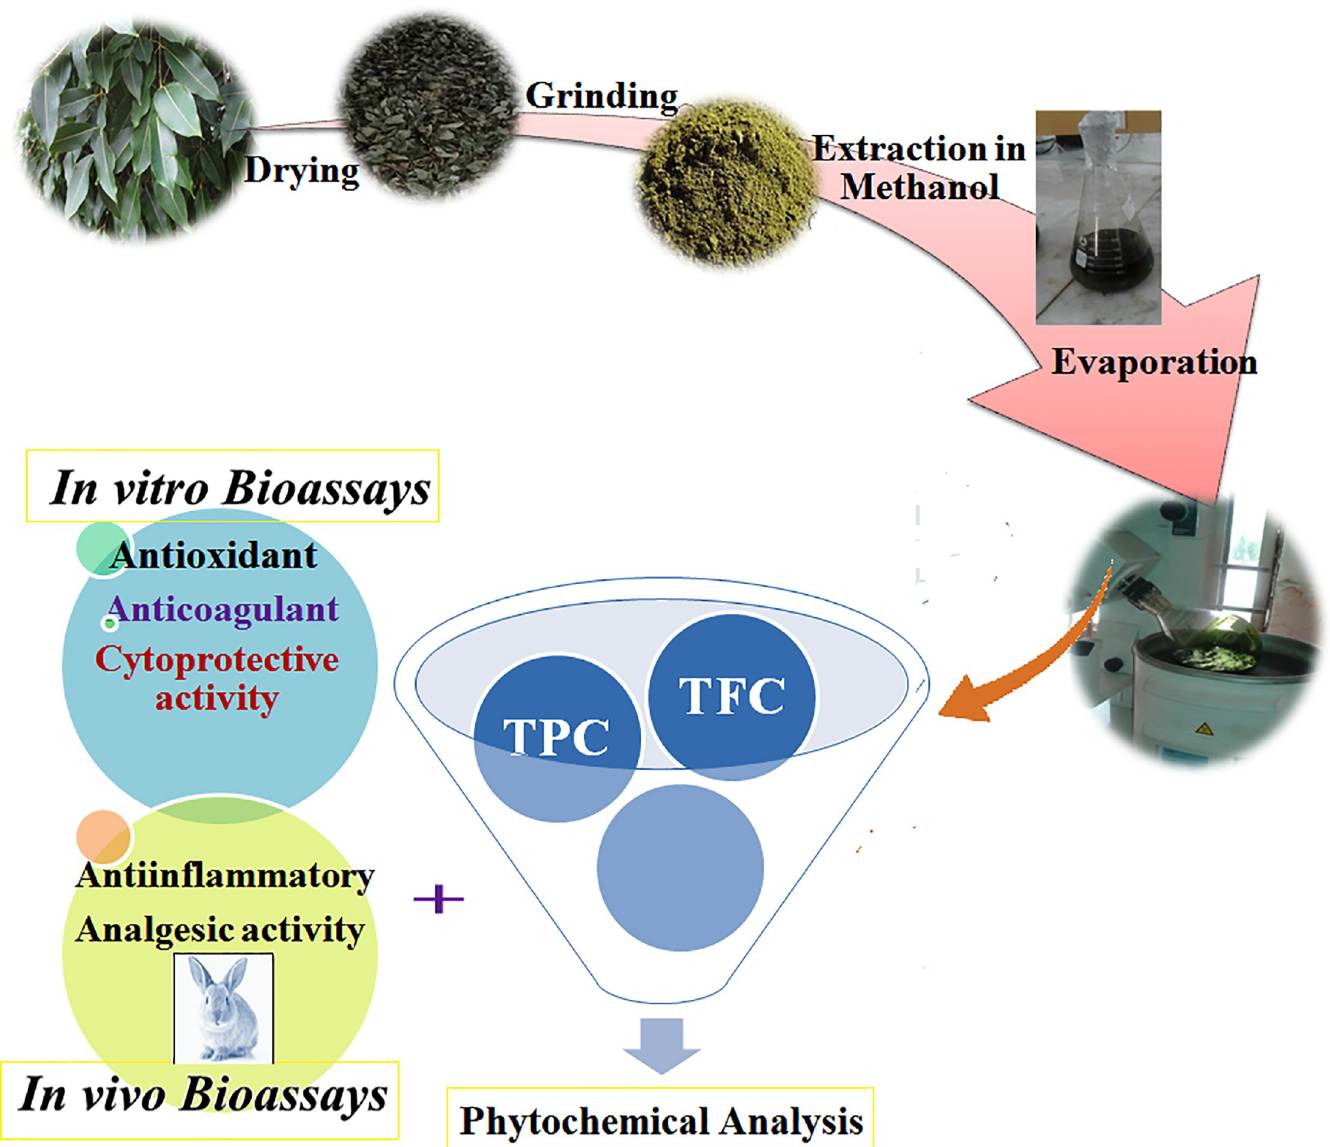
Fig 1. Graphical representation of experimental process for the whole study.